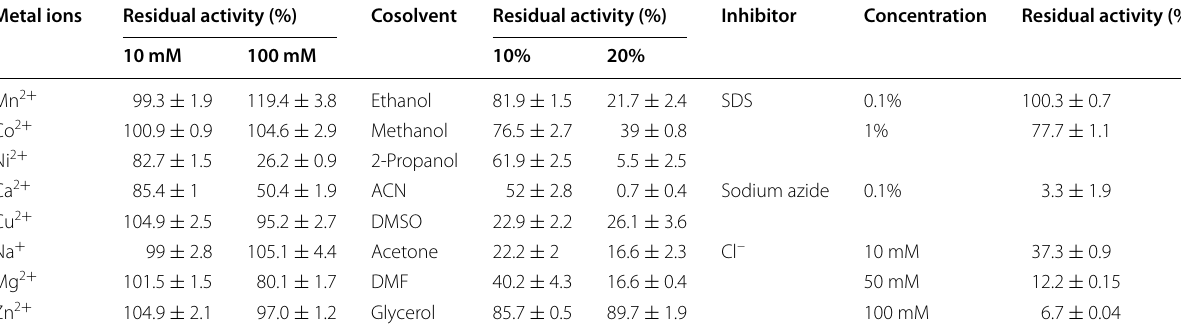
Table 4 Residual activity of Mrl2 towards ABTS in presence of different metal ions, cosolvents and